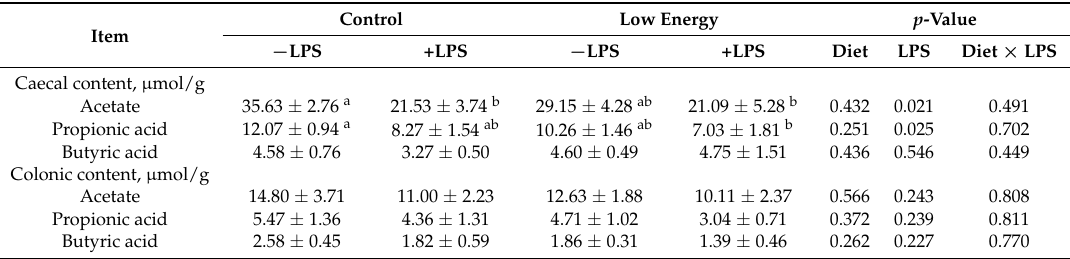
Escherichia coli